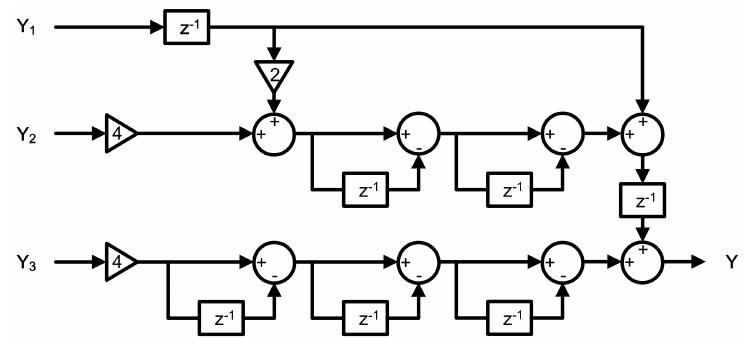
Figure 8. Digital noise cancellation logic